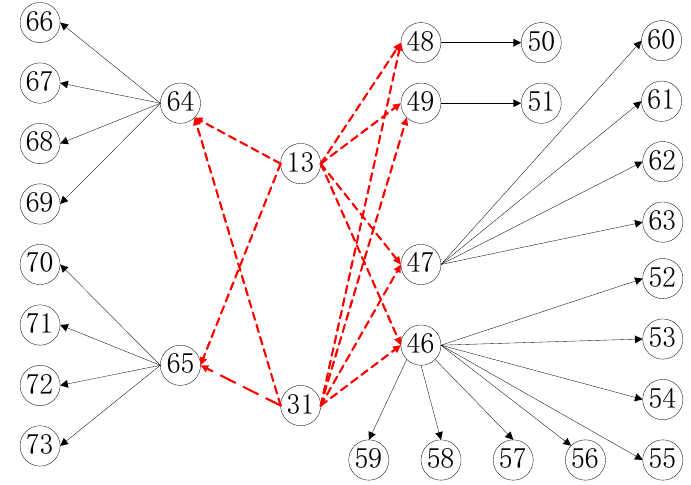
Figure 8. Processing constraint relationship